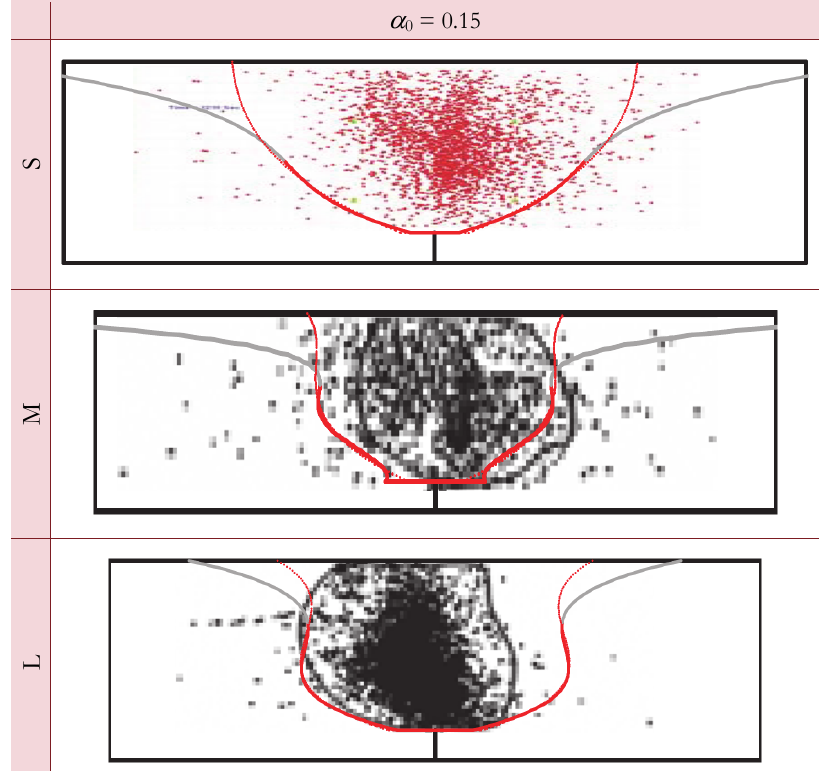
Figure 9: Notched beams of all tested sizes with the shortest relative notch length with the indication of the envelope of the FPZ for the FEM simulated response compared to localized AE events (top figure adopted from [26], middle and bottom from